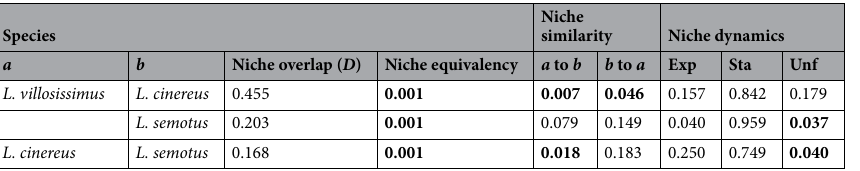
Table 3. Pairwise niche comparisons among three species of hoary bat. Niche overlap estimates shown for statistical comparisons of niche equivalency and similarity for species combinations a and b . Niche overlap statistic (Schoener’s D ) range from 0 (i.e. niches have no overlap) to 1 (i.e. niches are identical). Based on pairwise comparisons of the observed Schoener’s D, P values of niche equivalency and niche similarity are presented in their respective columns. Values of niche equivalency and similarity shown in bold denote P < 0.05 for niche estimates that are significantly different (i.e. not equivalent) or more similar than expected by chance respectively for each statistic. Niche dynamics show estimated values of expansion (Exp.), stability (Sta.), and unfilling (Unf.) estimated from the data; values shown in bold resulted in P <